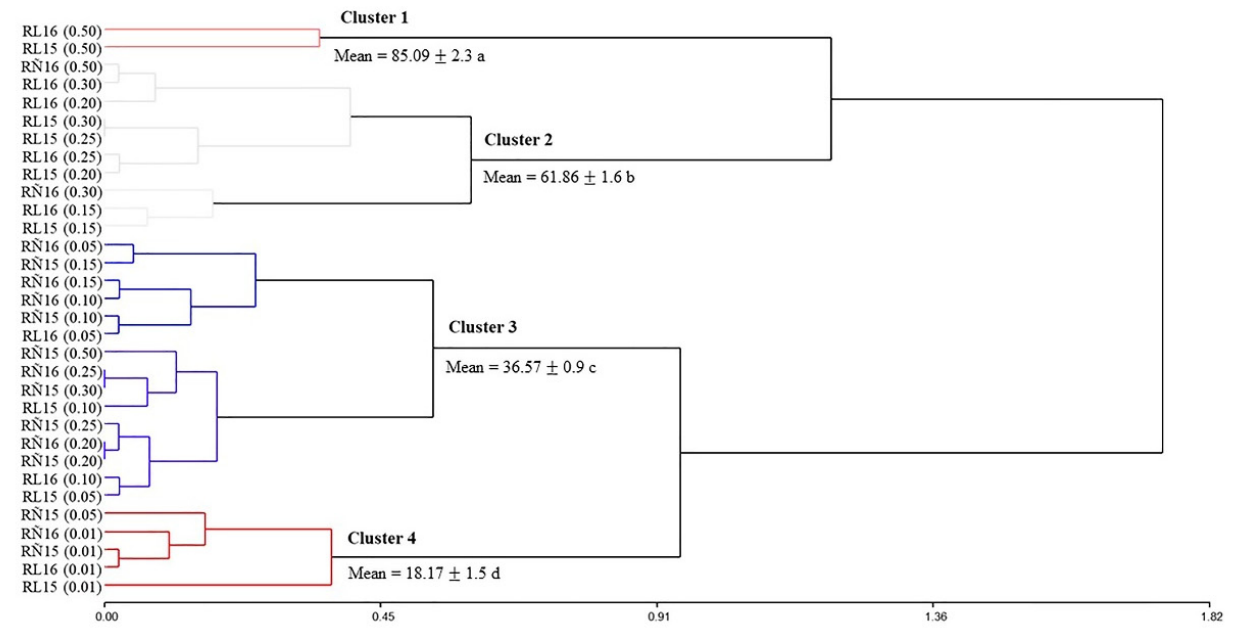
Figure 5. Phenogram of the cluster analysis of the inhibition of the mycelial growth of Phlyctema vagabunda (CP13 isolate) by the four propolis extracts (RÑ15, RÑ16, RL15, and RL16) at different concentrations (0.01, 0.05, 0.1, 0.2, 0.25, 0.3, and 0.5%). Average—average linkage and Euclidean distance. Means with the different letter is showing a significant difference ( p < 0.05) between clusters.